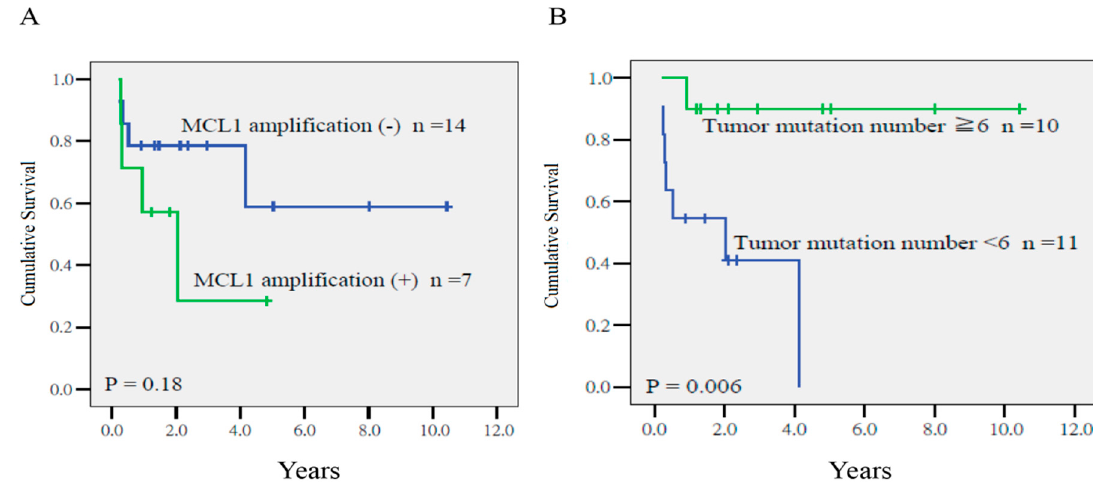
Figure 2. Local relapse-free survival in patients who had tumors with or without MCL1 amplification ( A ), and a high ( ≥ 6) or low tumor mutation number ( < 6) ( B ) ( p = 0.18 and p = 0.006,